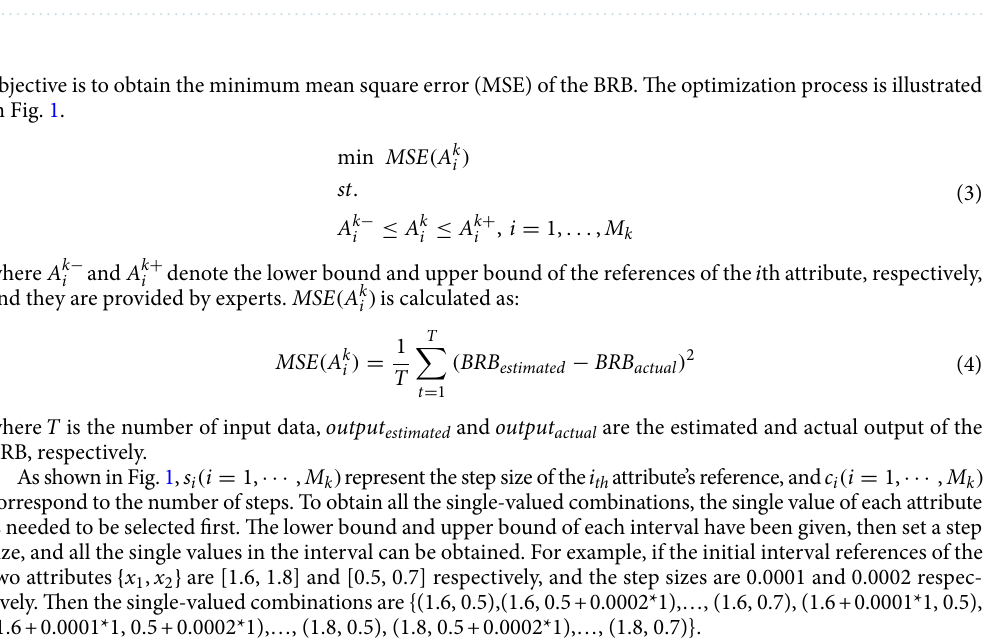
Table 1. Single-valued combinations for each